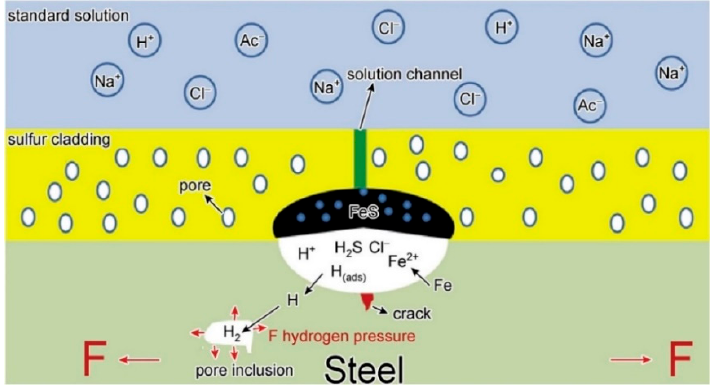
Figure 10. The SCC model for L360NS pipeline steel in sulfur melting cladding condition [9]. Reproduced with permission from [9], Elsevier, 2017.